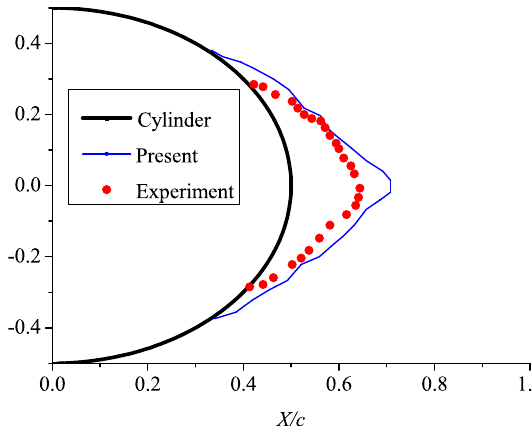
Figure 10. Comparison of calculation result and experimental result in droplet shadow zone. The area surrounded by the red dot is the droplet shadow zone obtained from the experiment [42], and the area surrounded by the blue line is the droplet shadow zone predicted by the tightly-coupled model.